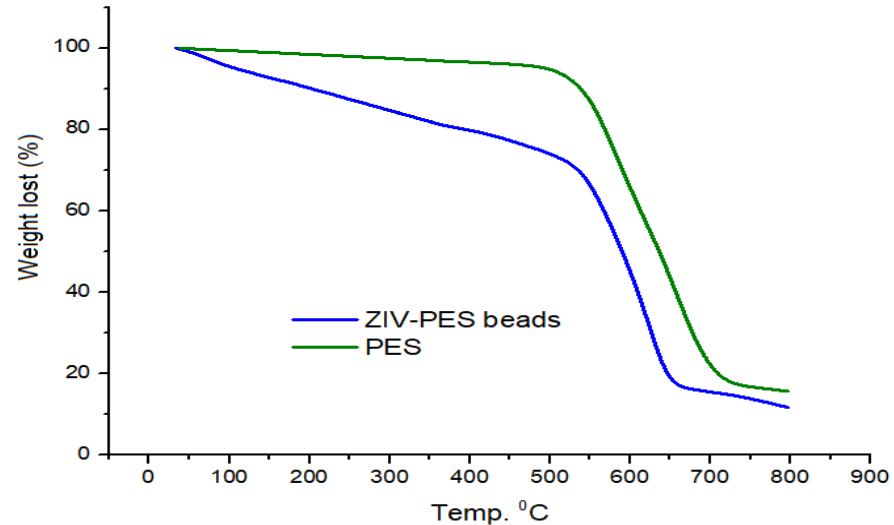
Figure 3. TGA curves of plain PES and PES/ZVI